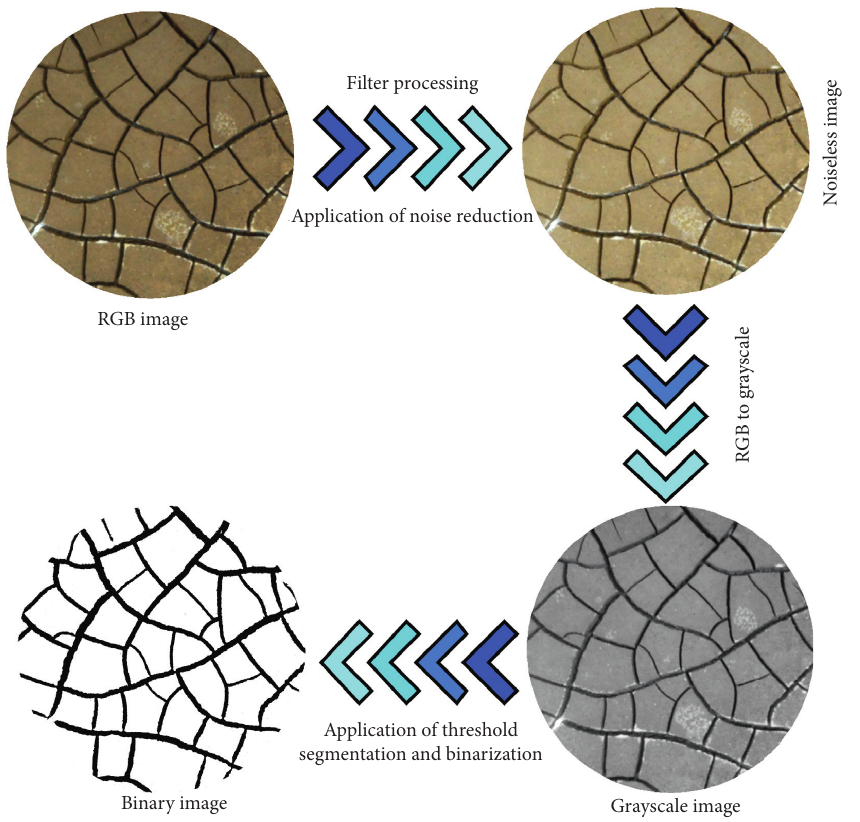
Figure 3: Processing of soil sample